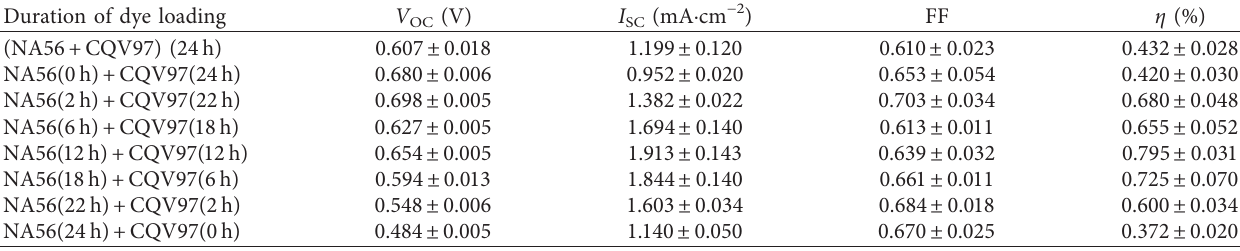
Table 1: Photovoltaic parameters a of cosensitizer sensitized by T film electrodes (3 samples in each group). Duration of dye loading